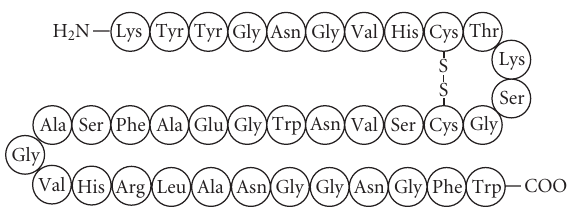
Figure 1: A representation of class IIa bacteriocin leucocin A, with the YGNGV consensus sequence and an N-terminal disulfide bridge.